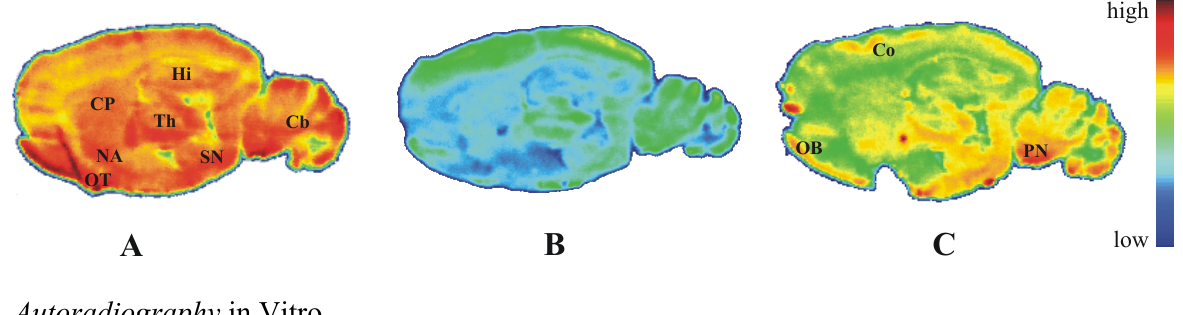
Figure 3. Representative color-coded autoradiographic images of sagittal rat brain slices. Distribution of radioactivity after 60 min of incubation with ( A ) 25 nM solution of [ 18 F] IV , ( B ) 25 nM [ 18 F] IV /10 μ M IV , and ( C ) 25 nM [ 18 F] IV /10 μ M MP-10. CP, caudate putamen; NA, nucleus accumbens; OT, olfactory tubercle; Th, thalamus; Hi, hippocampus; SN, substantia nigra; Cb, cerebellum; Co, cortex; OB, olfactory bulb; PN, pontine